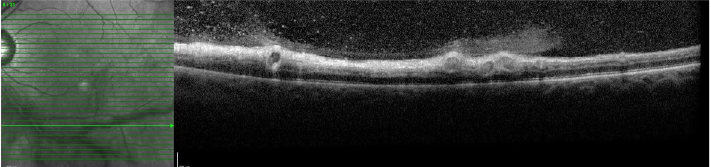
Fig. 1 OCT of a patient with active retinal vasculitis in Behcet’s Disease showing enlarged retinal vessels with hyperreflective walls, hyperreflective lumens and adjacent